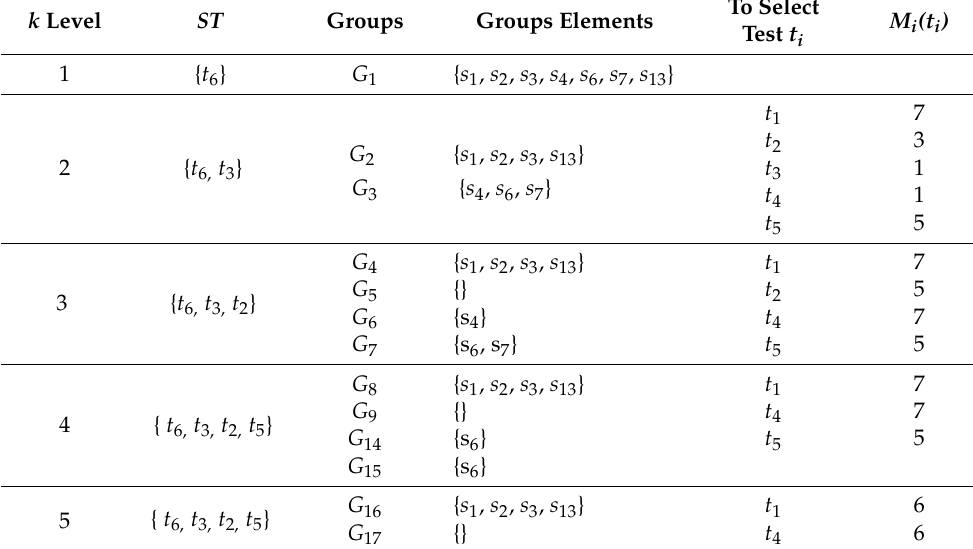
Table 2. Process of MADAG